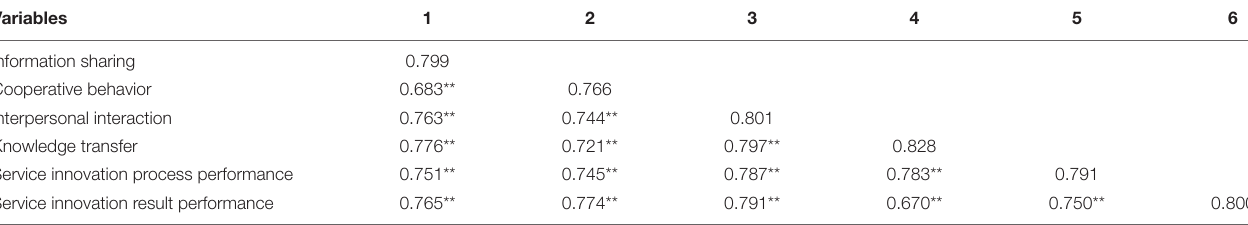
TABLE 3 | Correlation analysis between variables.